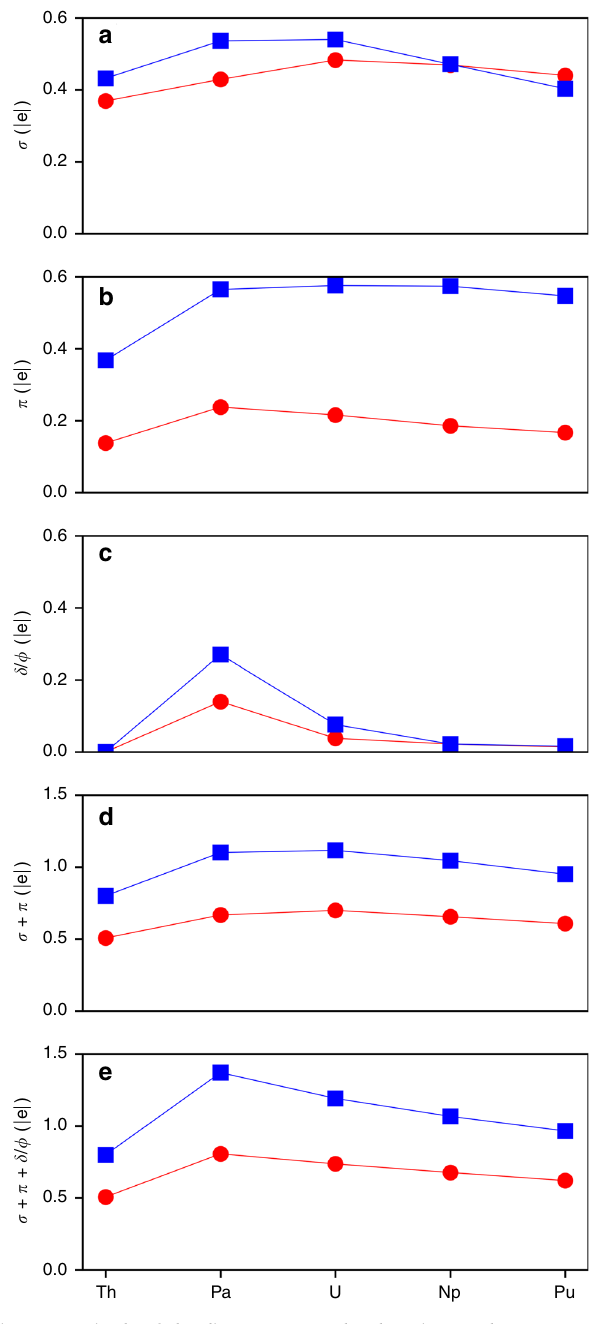
Fig. 6 Magnitude of the direct L – M σ and π donations and M – L δ or φ back-donations between the C 2 (SiMe 3 ) 2 (propene series ( δ ), red circles) and C 4 (SiMe 3 ) 2 (cumulene series ( φ ), blue squares) ligands and the M center in the Th – Pu series. a L – M σ donation. b L – M π donation. c M – L δ /